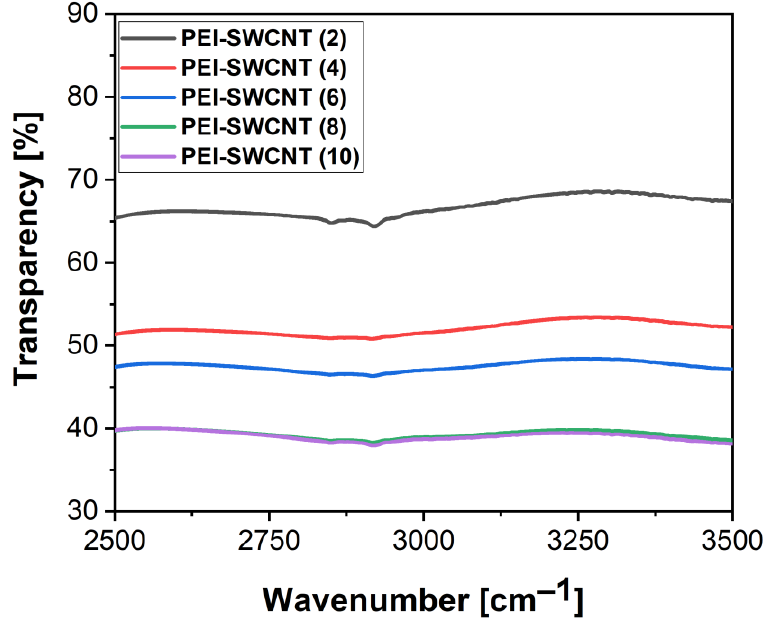
Figure 7. FTIR spectra of PEI+SWCNT with up to 10 bilayers in the IR spectral range. The electrical conductivity of the films was measured by four-point probe method, repeating the procedure over at least three positions across the samples to confirm homo- geneity. Even though the sheet resistance was not as low as expected, a decreasing trend was recorded with the number of bilayers deposited with low-purity SWCNT-COOH.